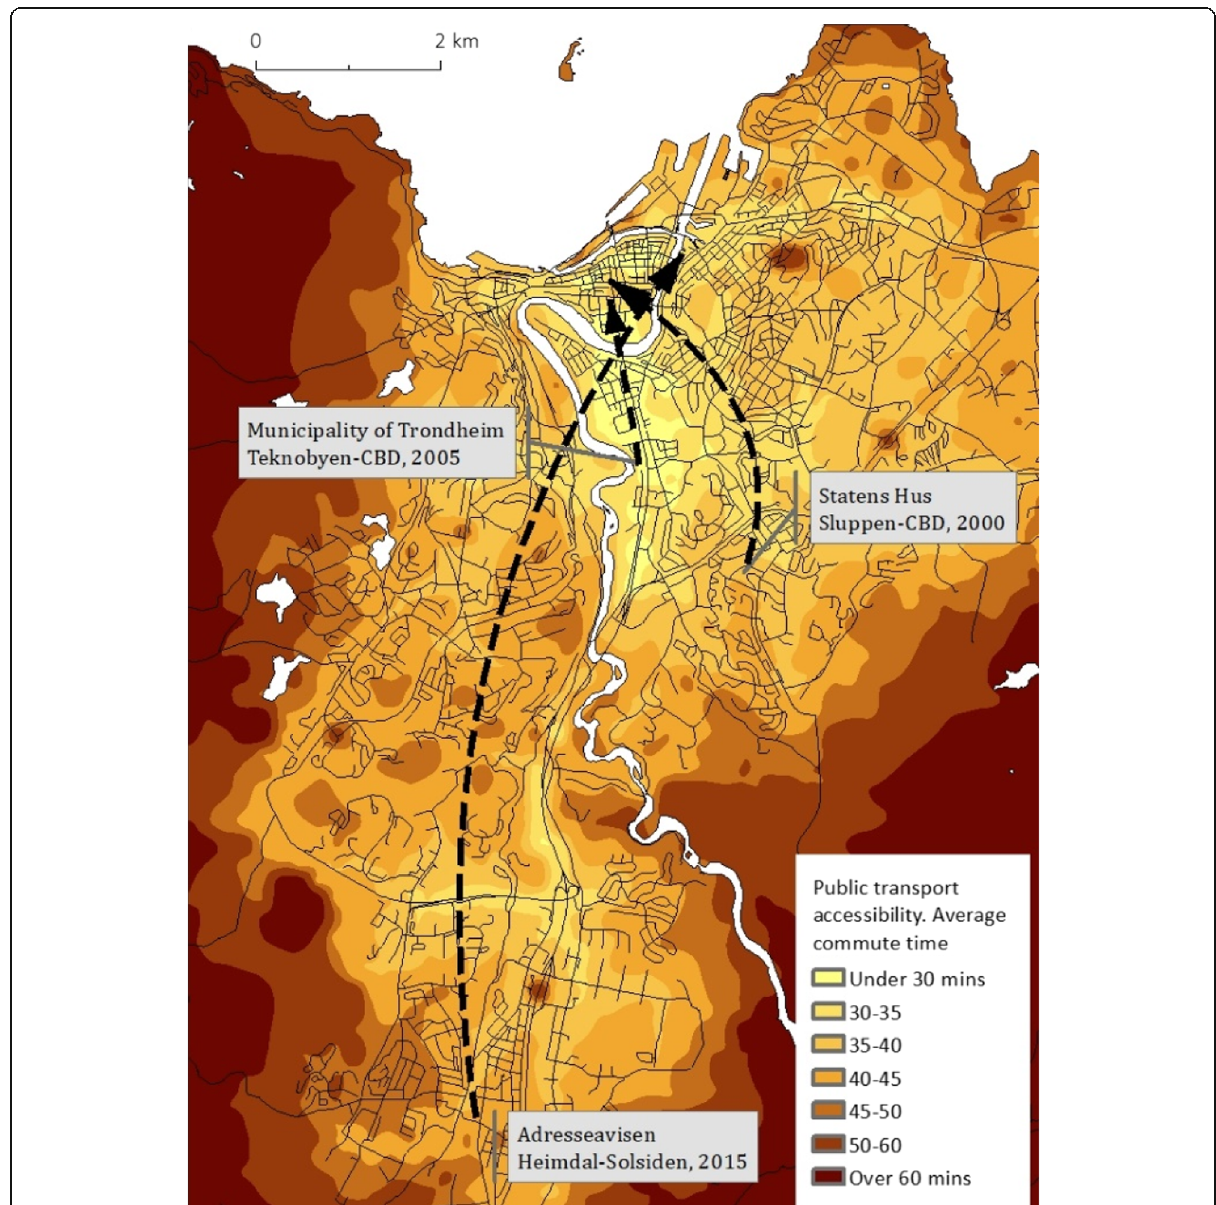
Fig. 1 Workplace relocation cases in Trondheim, Norway. The arrow connects the former location with the new location. Label format: [Name of organisation, former location – new location,